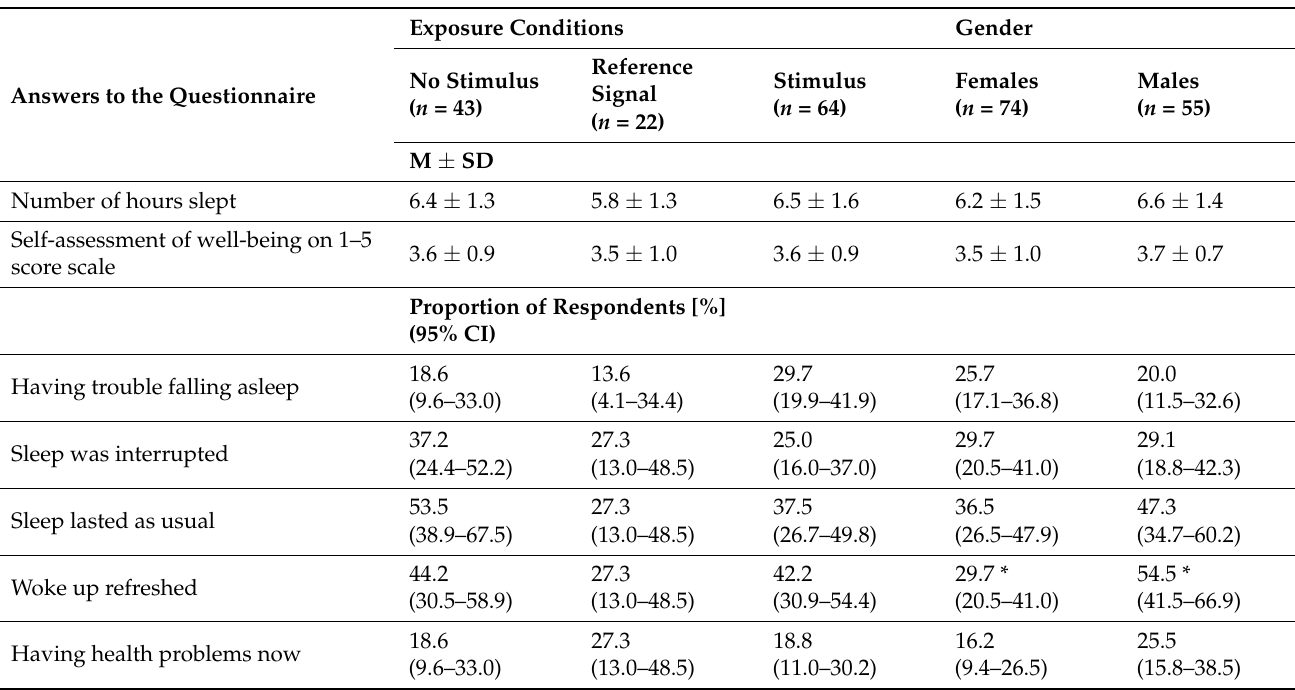
Table 1. Answers to the pre-exposure questionnaire in study subjects divided into subgroups according to exposure conditions and